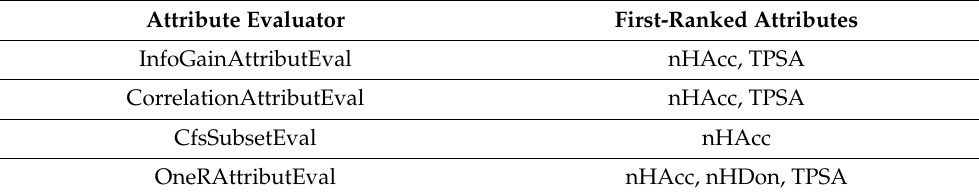
Table 2. Attribute evaluators and first-ranked attributes for each